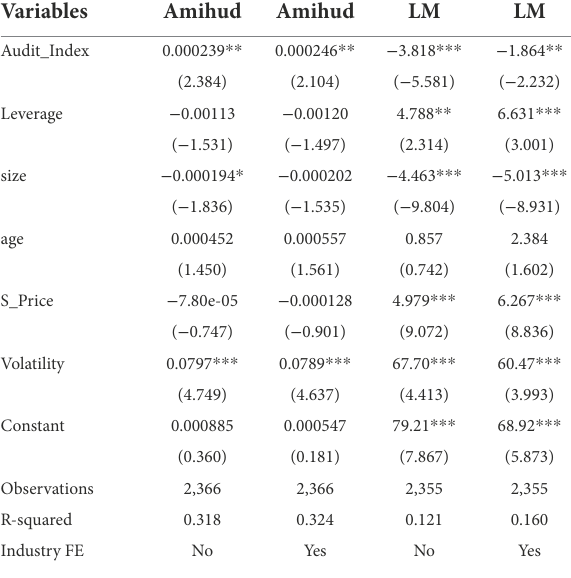
TABLE 6 Audit committee index and stock liquidity (OLS Regression). TABLE 7 Audit committee index and stock liquidity (2SLS